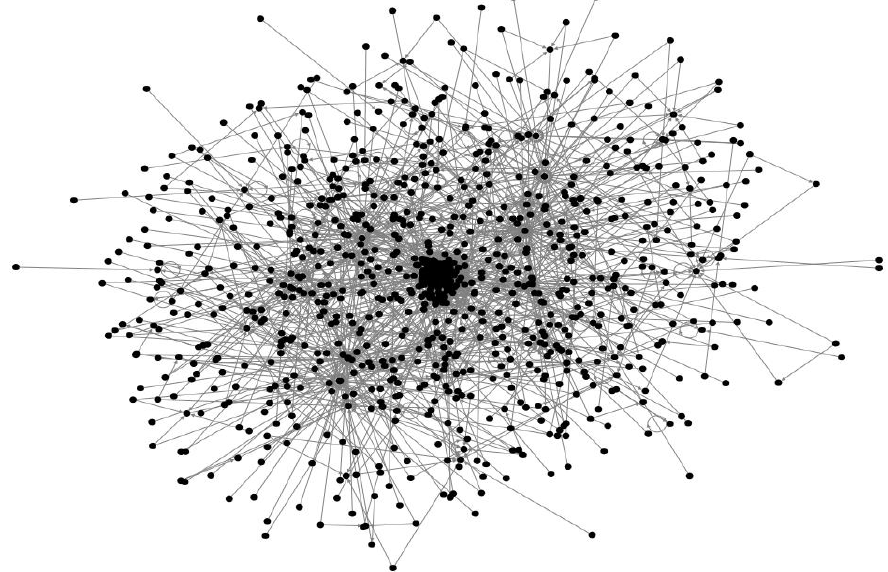
Figure 1. The number of likes based on posts by the tourism authority.